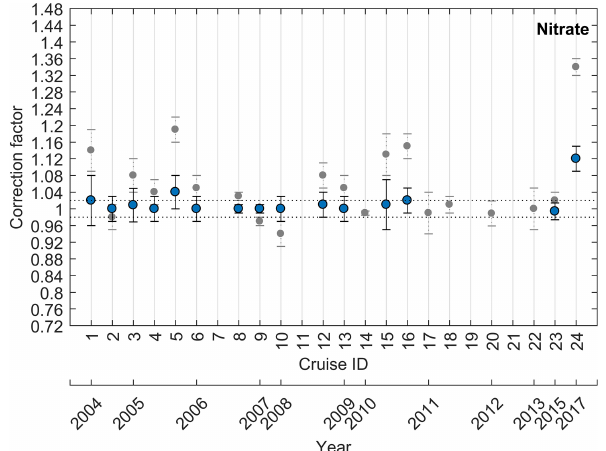
Figure 6. The same as Fig. 5 but for